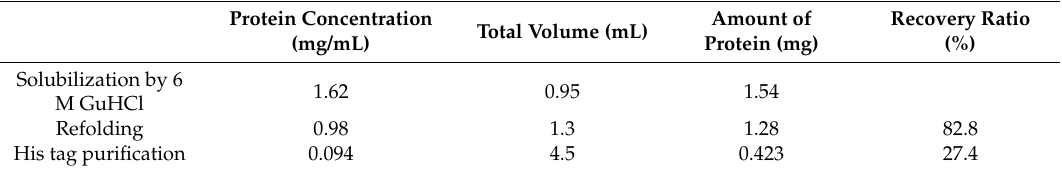
Table 1. Recovery of refolding and purification of 22 G clone expressed in E. coli Shuffle T7 Express. Protein Concentration